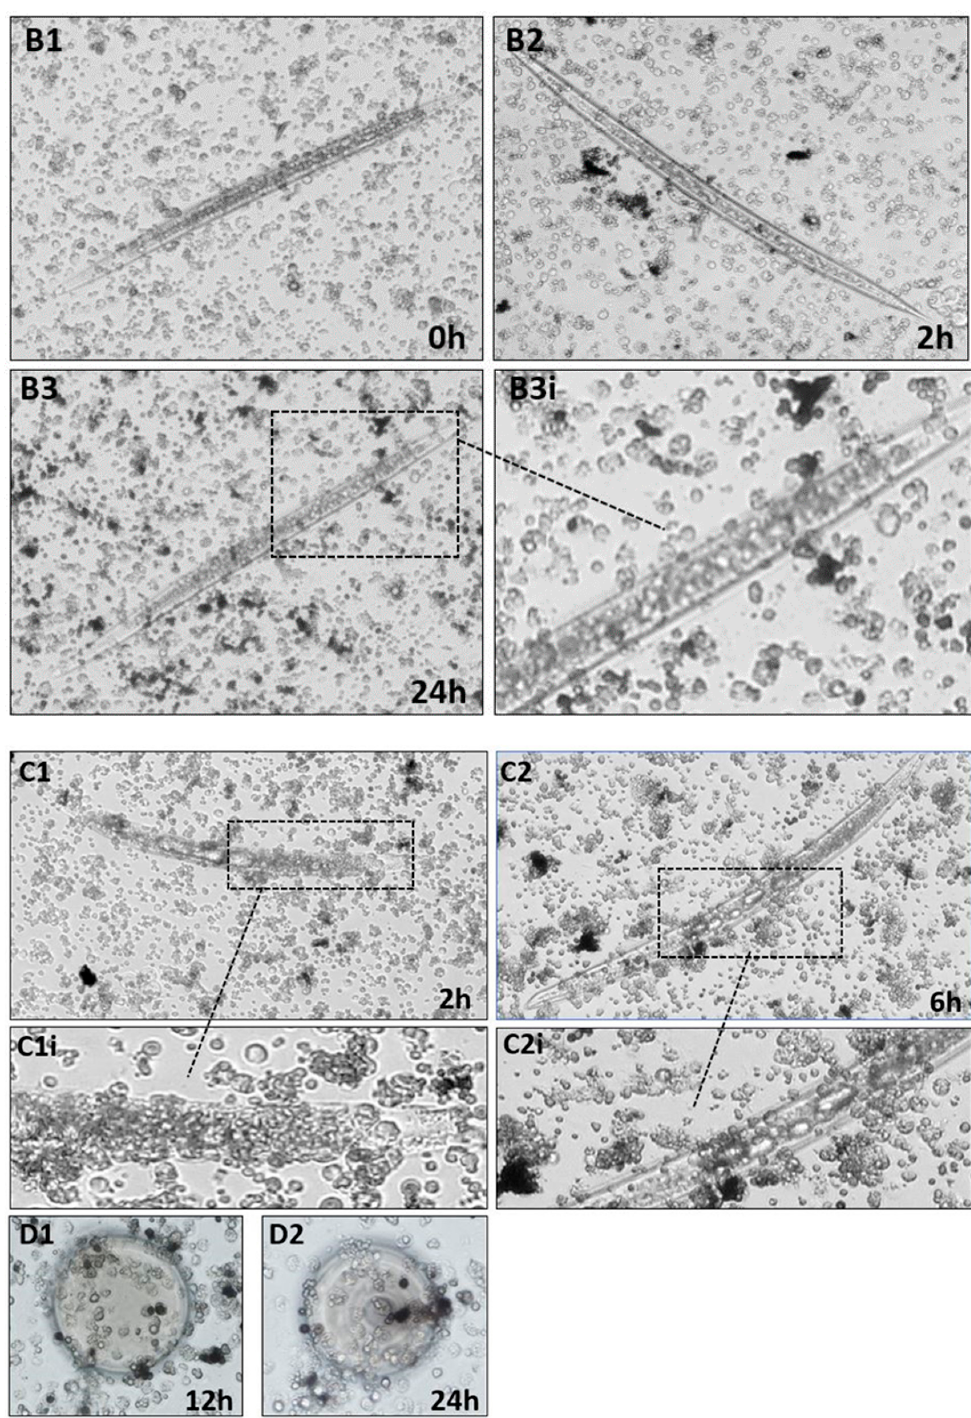
Figure 5. ( A – B ) In vitro encapsulation assays of S. carpocapsae by hemocytes of D. suzukii larvae. Nematodes were co-incubated with hemocytes. From top to bottom: alive nematodes at 0 h ( A1 ), 2 h ( A2 ) and 24 h ( A3 ), A3i inset is an enlargement of A3. Cold-killed nematodes at 0 h ( B1 ), 2 h ( B2 ), and 24 h ( B3 ), B3i inset is an enlargement of B3. A1 (200×); A2, A3, B1, B2, B3 (100×). ( C – D ). In vitro encapsulation assay of lipase treated dead nematodes at 2 h ( C1 ) and 6 h ( C2 ), C1i and C2i are enlargements of the respective images. In vitro encapsulation of agarose beads, at 12 h ( D1 ) and 24 h ( D2 ). C1 and C2 (100×); D1 and D2 (200×).